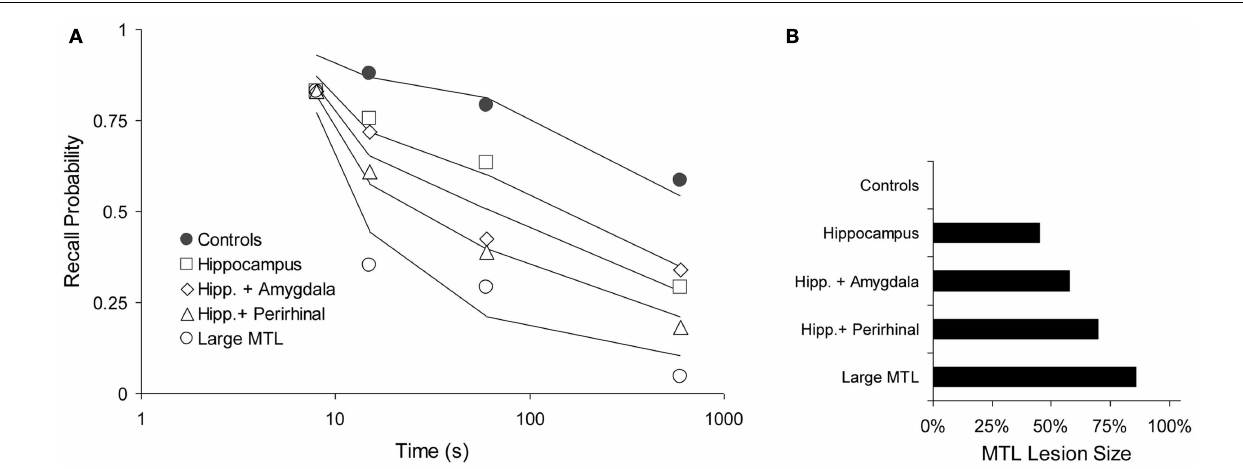
FIGURE 8 | Forgetting with various levels of anterograde amnesia caused by increasing lesion sizes in a DNMT task (Squire and Zola-Morgan, 1991). (A) Data (points) and model fit (solid lines). Performance as a function